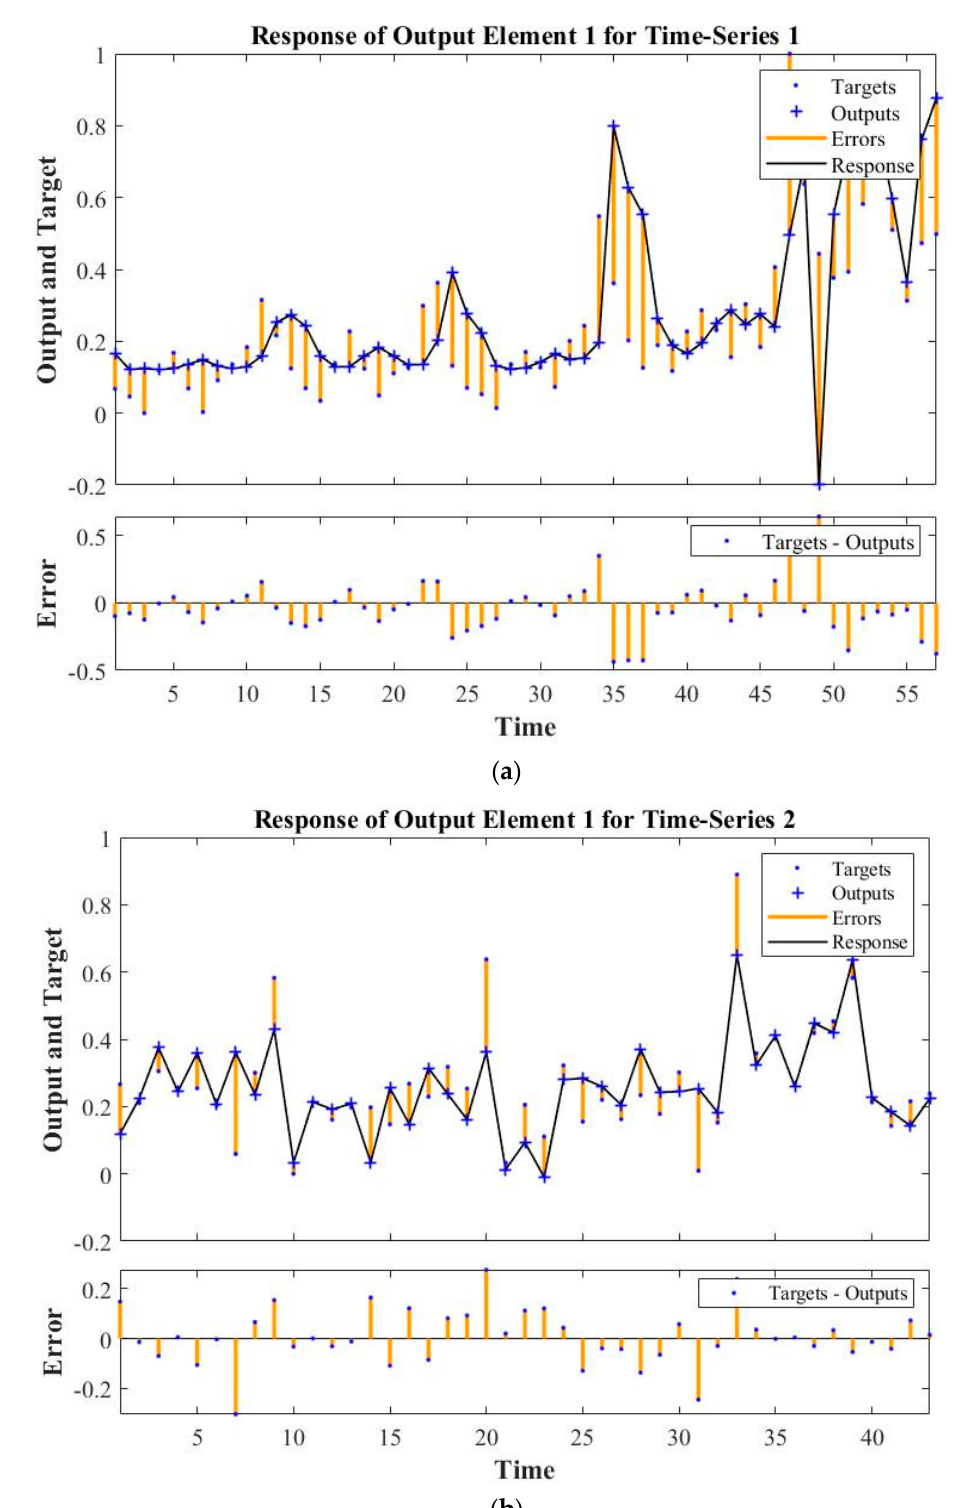
Figure 7. Residuals after NAR modelling. ( a ) Original traffic volume time series. ( b ) SARIMA model residual series.